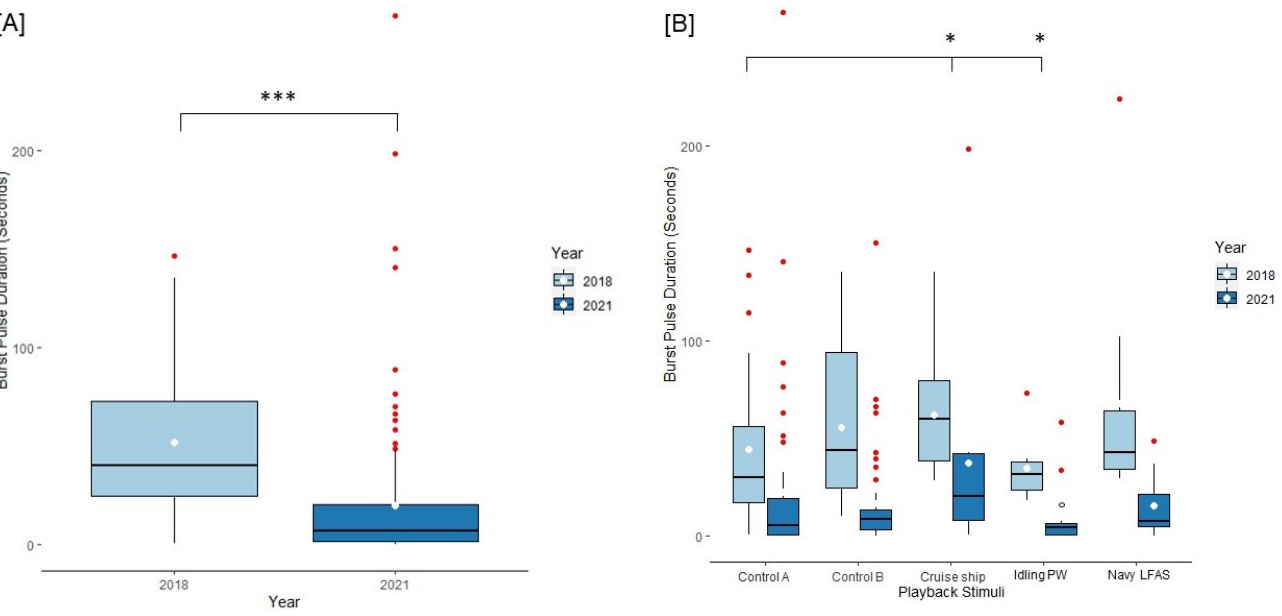
Figure 7. Echolocation Bout Duration Responses separated by fi xed e ff ect factors. ( A ) Box and whisker plot representing the IQR and medians of echolocation duration responses in 2018 and 2021 visits. Means are represented by white dots. ( B ) Box and whisker plot representing data range of echolocation durations by playback type with outliers denoted in red. * = p < 0.05, ** = p < 0.01, *** = p < 0.001. Idling PW = idling personal watercraft.